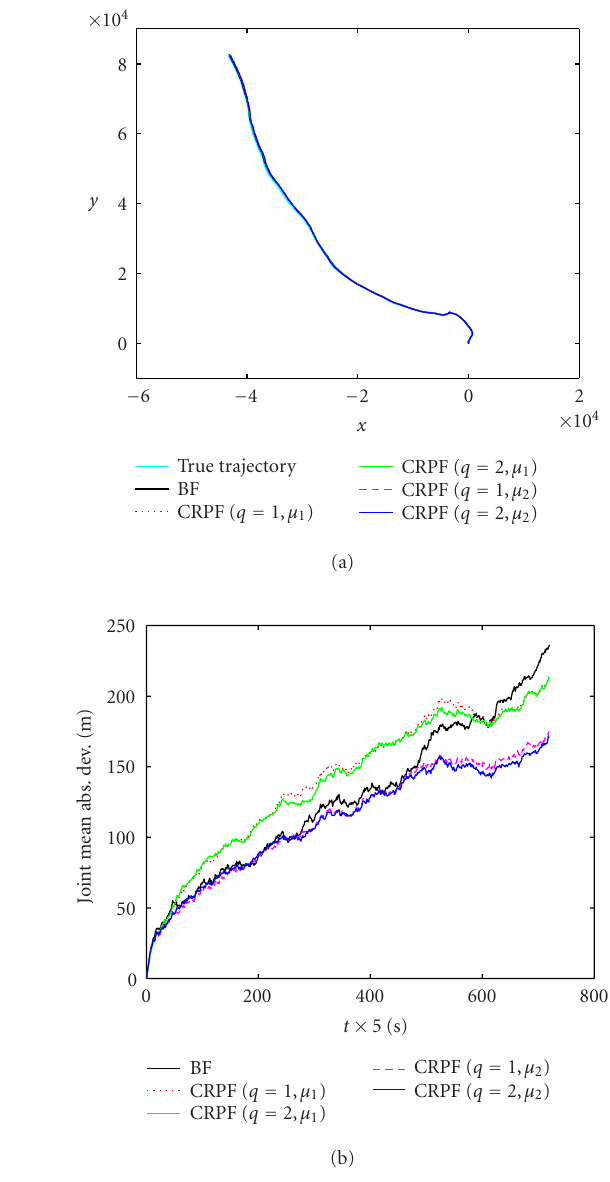
Figure 3: Mixture Gaussian noise processes. T s = 5 seconds. (a) Trajectory. (b) Mean absolute